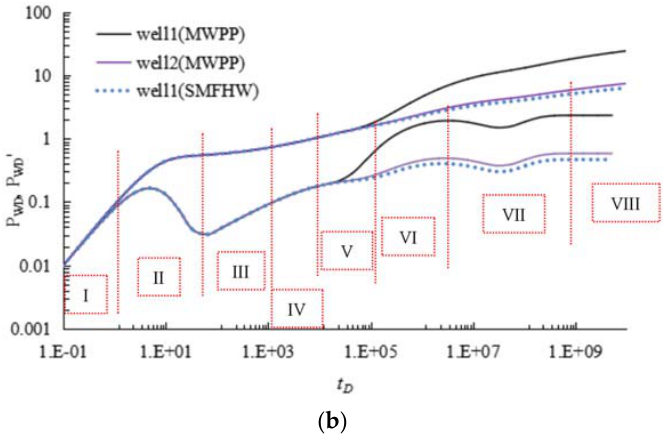
Figure 7. Comparison of pressure curves between WIPS and SMFHWs ( q 1 :q 2 = 1:4): ( a ) Figure 1b, case 1; ( b ) Figure 1b, case 2.